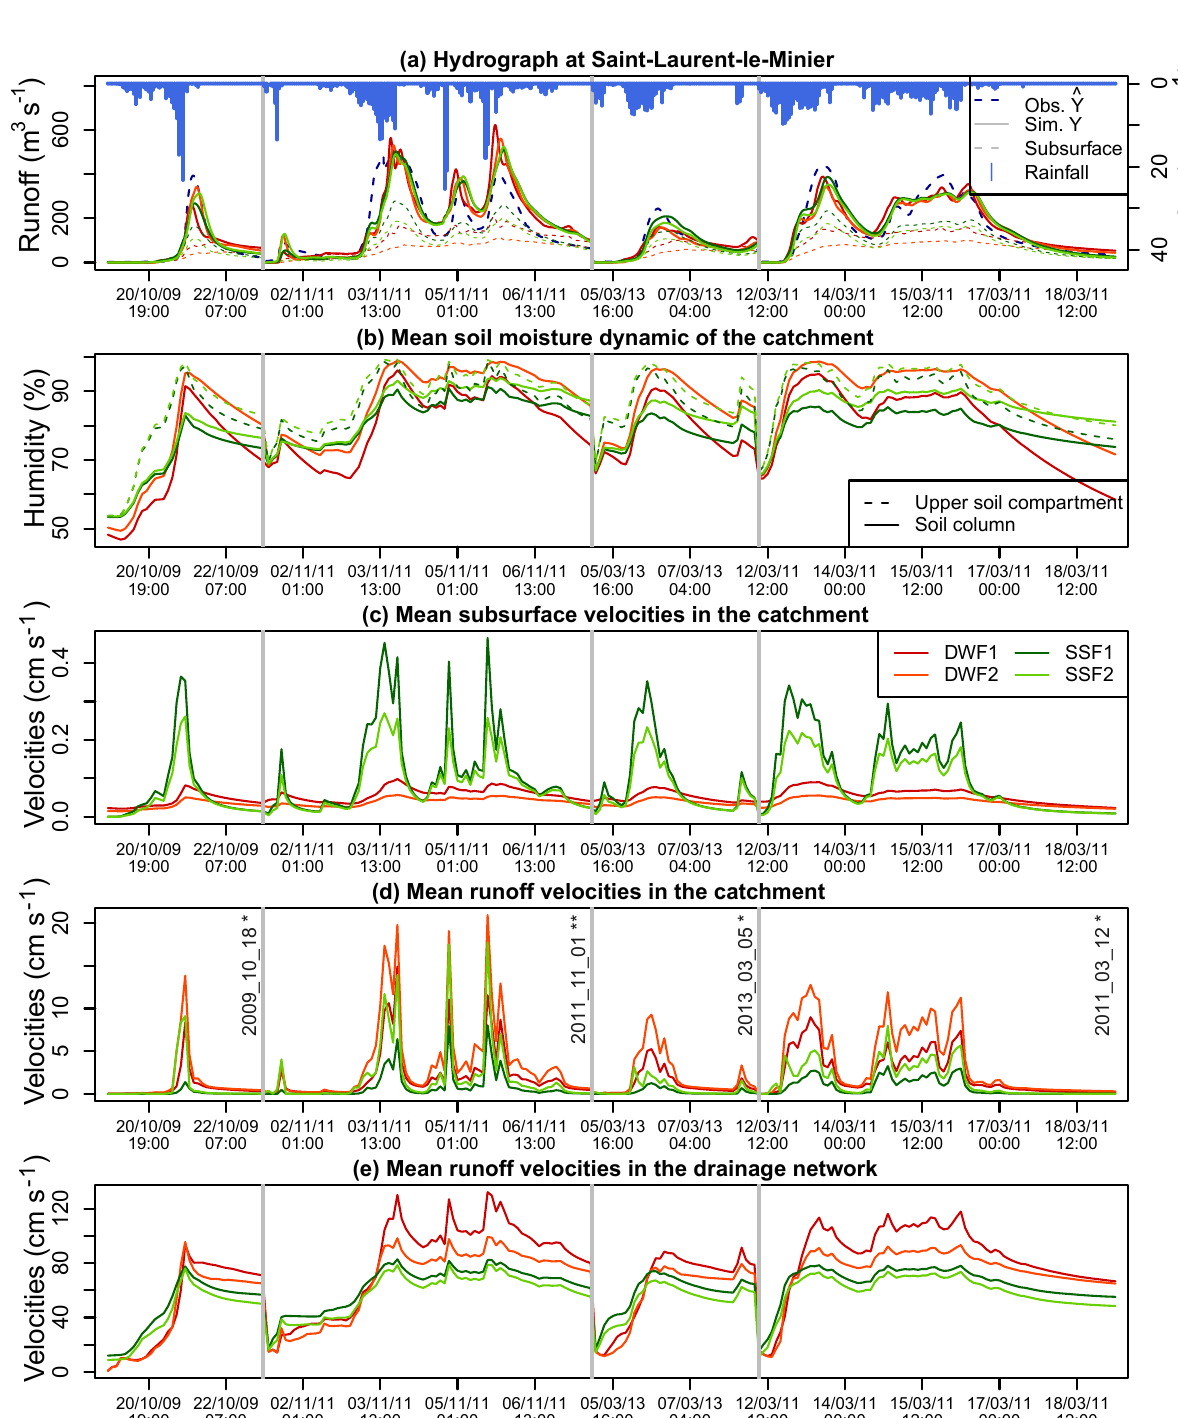
Figure 12. Comparison of the results of four equally plausible simulations for the Hérault at Saint-Laurent-le-Minier (Table 3). (a) Flood hydrographs (solid lines) and outlet flows transiting via the soil (dashed lines). (b) Evolution in the overall moisture content of the soil column. (c) Evolution in simulated mean velocities in the subsoil horizon (DWF model) and in the upper part of the soil column (SSF model). (d) Average runoff velocities on the hillslopes. (e) Average runoff velocities in the drainage network. Denoted are events of calibrations ( ∗ ) and events of validation ( ∗∗